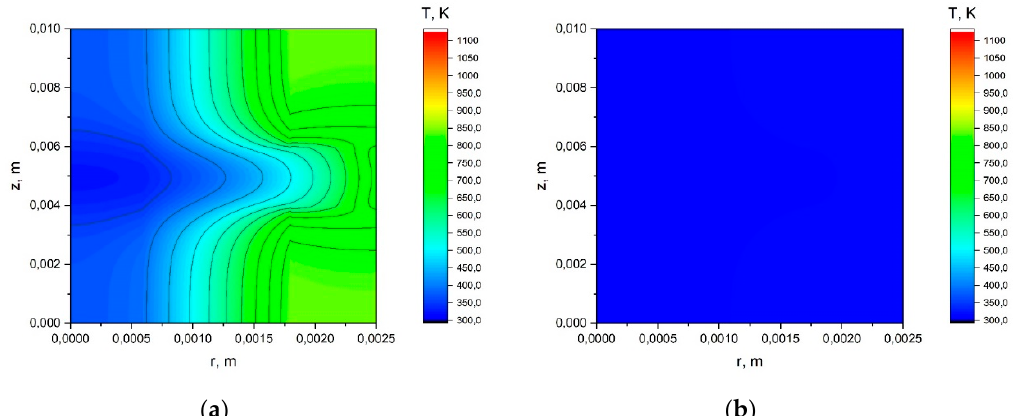
Figure A22. Temperature distribution in the stem of a herbaceous plant: R = 0.0025 m, t = 3 s, q = 30kW/m 2 ( a ); R = 0.0025 m, t = 6 s, q = 0.5 kW/m 2 ( b ).